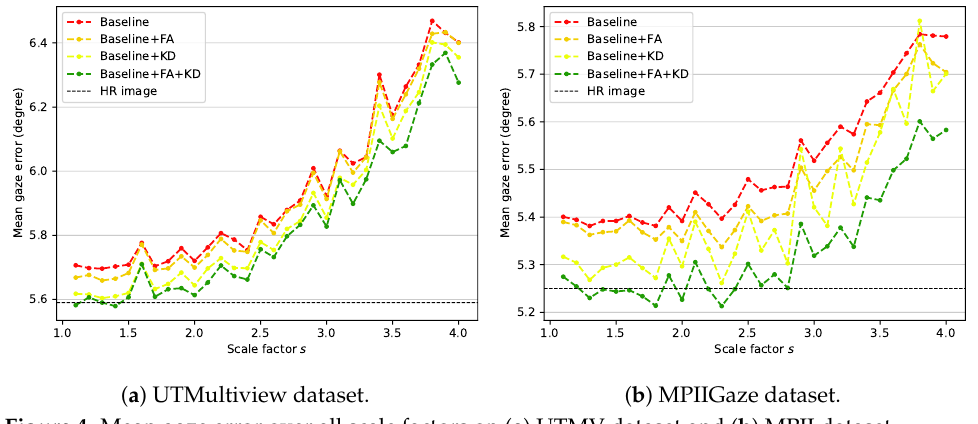
Figure 4. Mean gaze error over all scale factors on ( a ) UTMV dataset and ( b ) MPII dataset. For statistical tests, the paired t-test is performed using the mean gaze errors of the proposed method ( Baseline + FA + KD ) and the Baseline over 15 leave-one-person-out cross-validation folds of the MPII dataset. Figure 5 visualizes the calculated p -values. For all scale factors except s = 1.1, the p -value is less than 0.05. As the scale factor increases, the p -value decreases. This result shows that the performance gain of the proposed method is statistically significant, especially for high scale